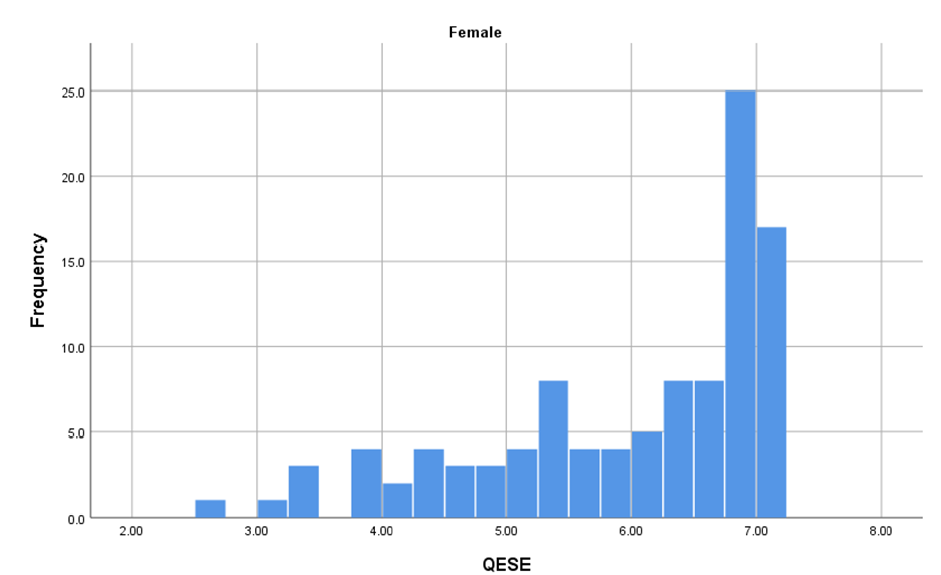
Figure 5. Distribution of scores for the QESE scale for female